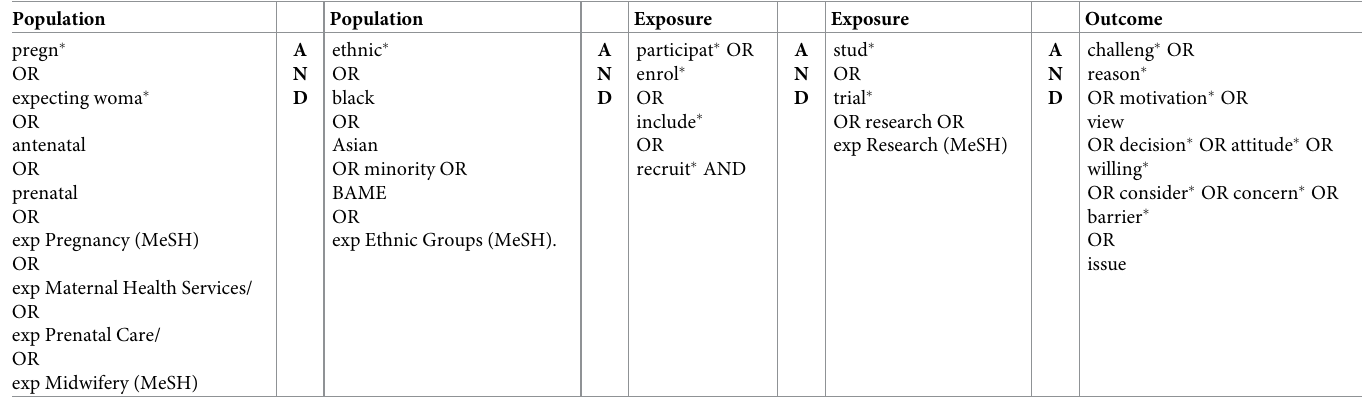
Table 1. PEO analysis of search